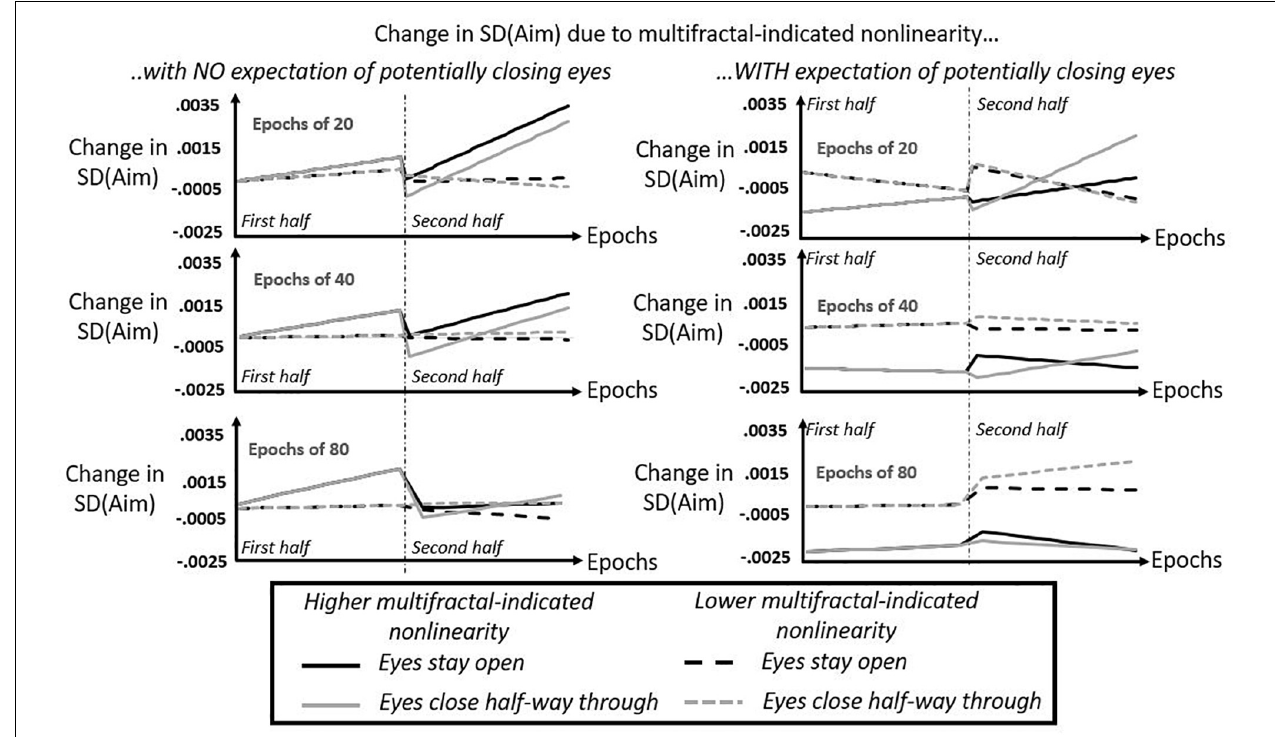
FIGURE 7 | Model predictions from regression of SD(Aim) by expectation of potentially closing eyes, by epoch, by half of task, by t MF , and by eyes being closed or open. Solid lines show model-predicted contributions of multifractal-indicated non-linearity to aiming variability at the hand (SD[Aim]) for higher t -statistics t MF (predictions shown specifically for 3rd quartile of t MF ) for participants keeping their eyes open in the second half (black solid lines) and for participants closing their eyes for the duration of the second half (gray solid lines). Dashed lines show model-predicted contributions of multifractal-indicated non-linearity to aiming variability at the hand (SD[Aim]) for lower t -statistics t MF (predictions shown specifically for 1st quartile of t MF ) for participants keeping their eyes open in the second half (black solid lines) and for participants closing their eyes for the duration of the second half (gray solid lines). Dash-and-dotted vertical lines separates the first and second halves of the task, and it is noteworthy that gray and black lines are overlapping across the board in the first halves of the task. Left panels depict model predictions for participants without the expectation of potentially having to close their eyes, and right panels depict model prediction for participants with this expectation. Top, middle, and bottom panels depict model predictions for epochs containing 20, 40, and 80 cycles,